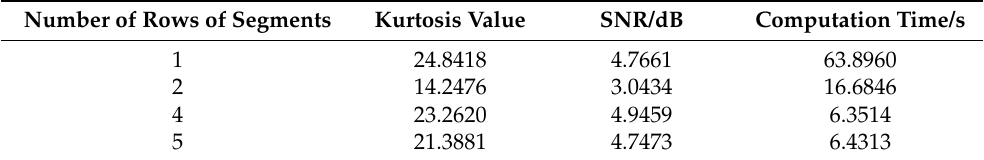
Figure 8. Hankel matrix segmentation test. ( a ) 1 segment; ( b ) 2 segments; ( c ) 4 segments; and ( d ) 5 segments. Table 5. Running results of K-SVD denoising with different number of segments of Hankel ma- trix.